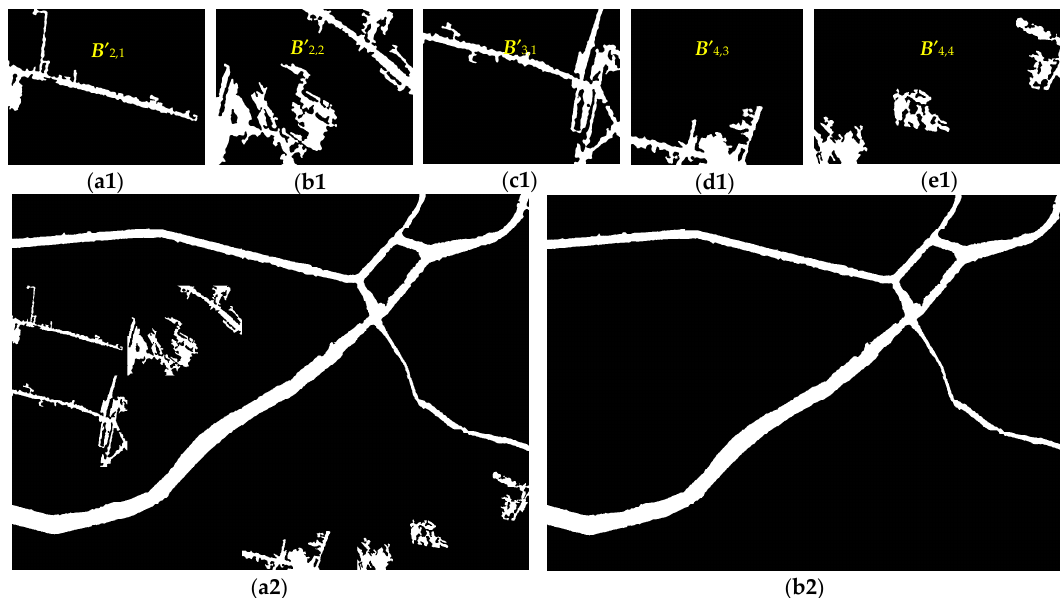
Figure 12. Example of riverway extraction from unclassified sub-image blocks. ( a1 )–( e1 ) Processing results of sub-image blocks without riverway cover. ( a2 )–( b2 ) Intermediate and final results of riverway extraction.